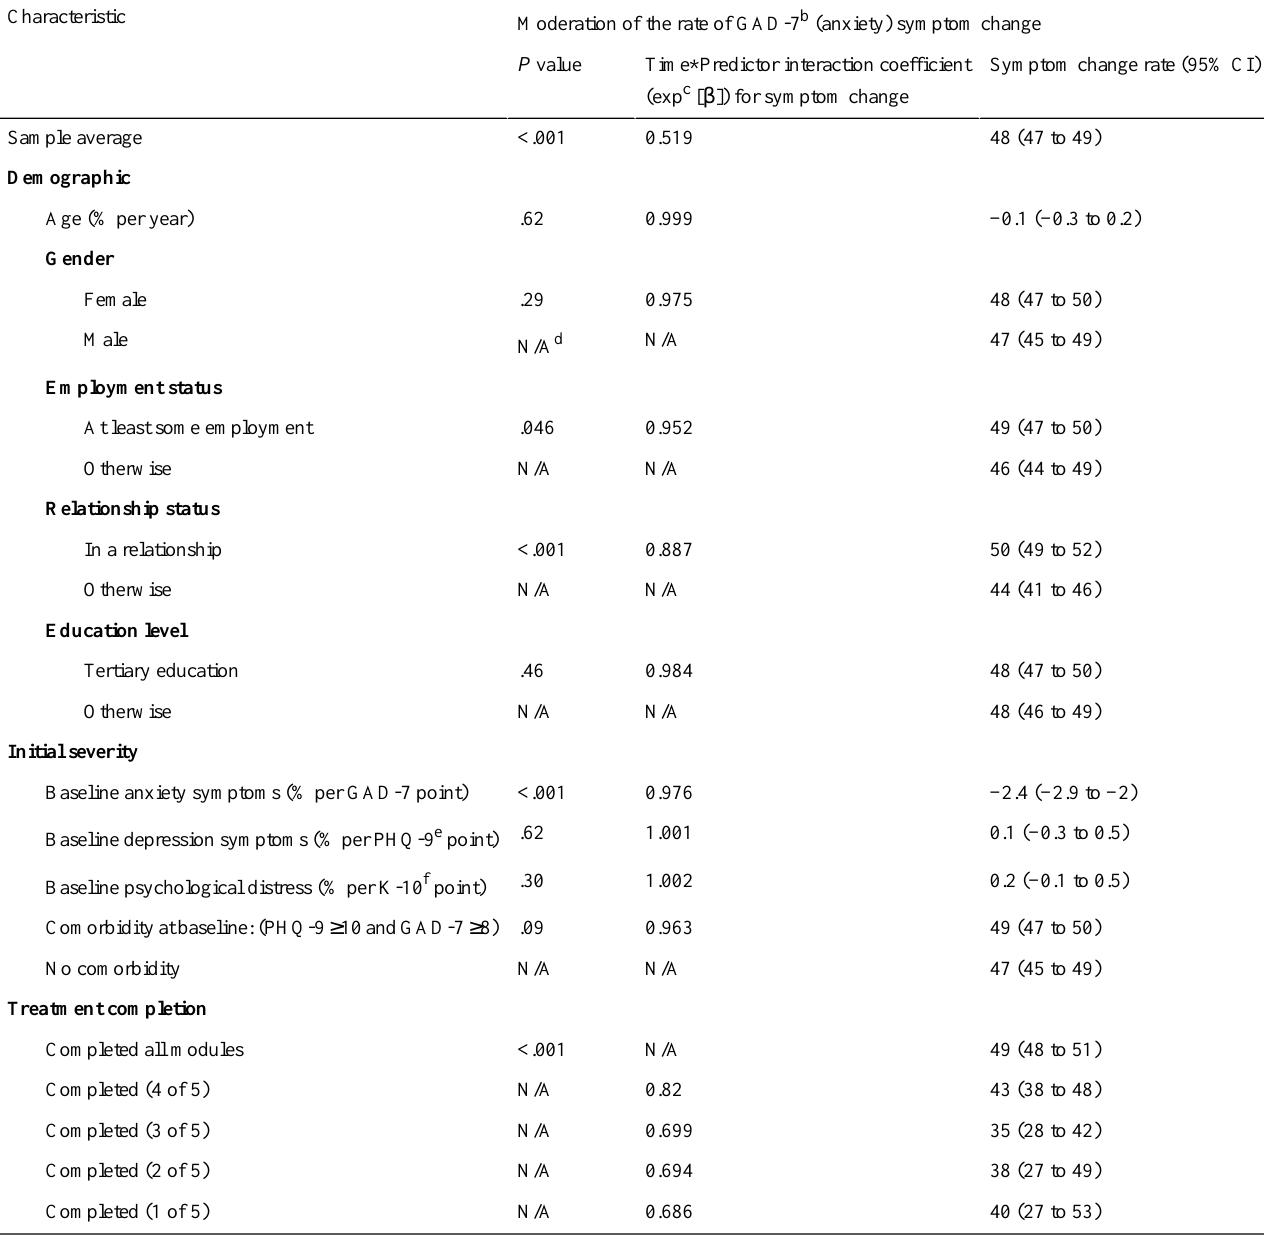
Table 5. Longitudinal estimates of average anxiety (generalized anxiety disorder-7) symptom moderation. a